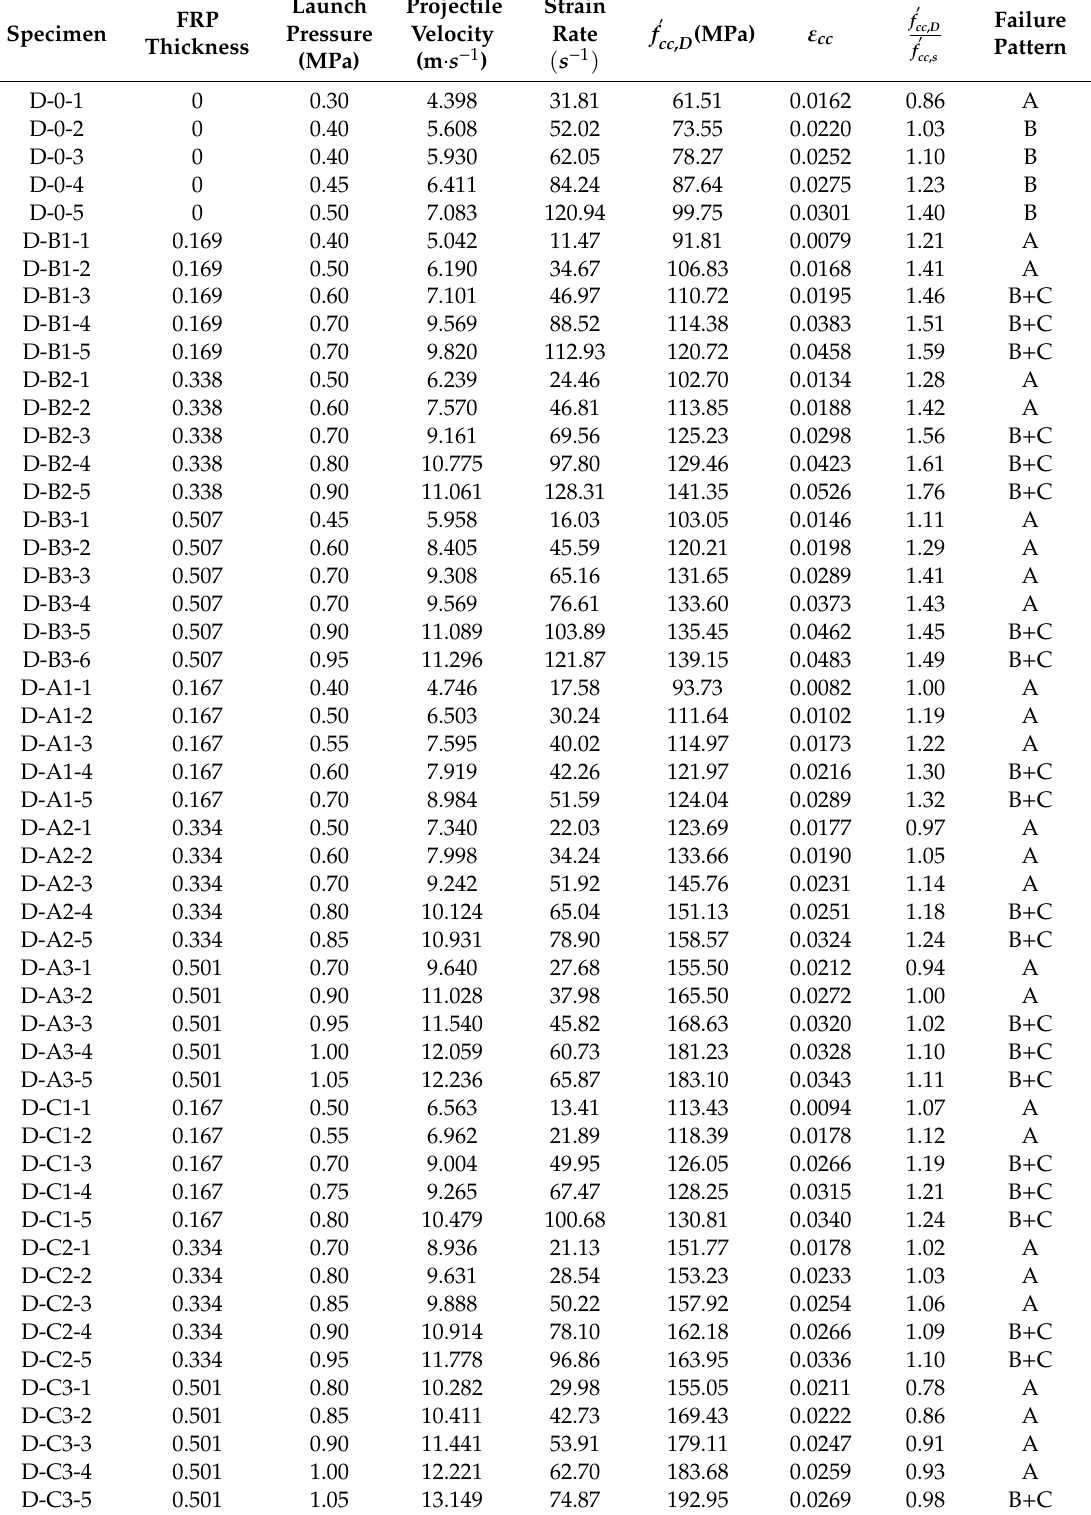
Table 4. Test results of specimens under dynamic compression